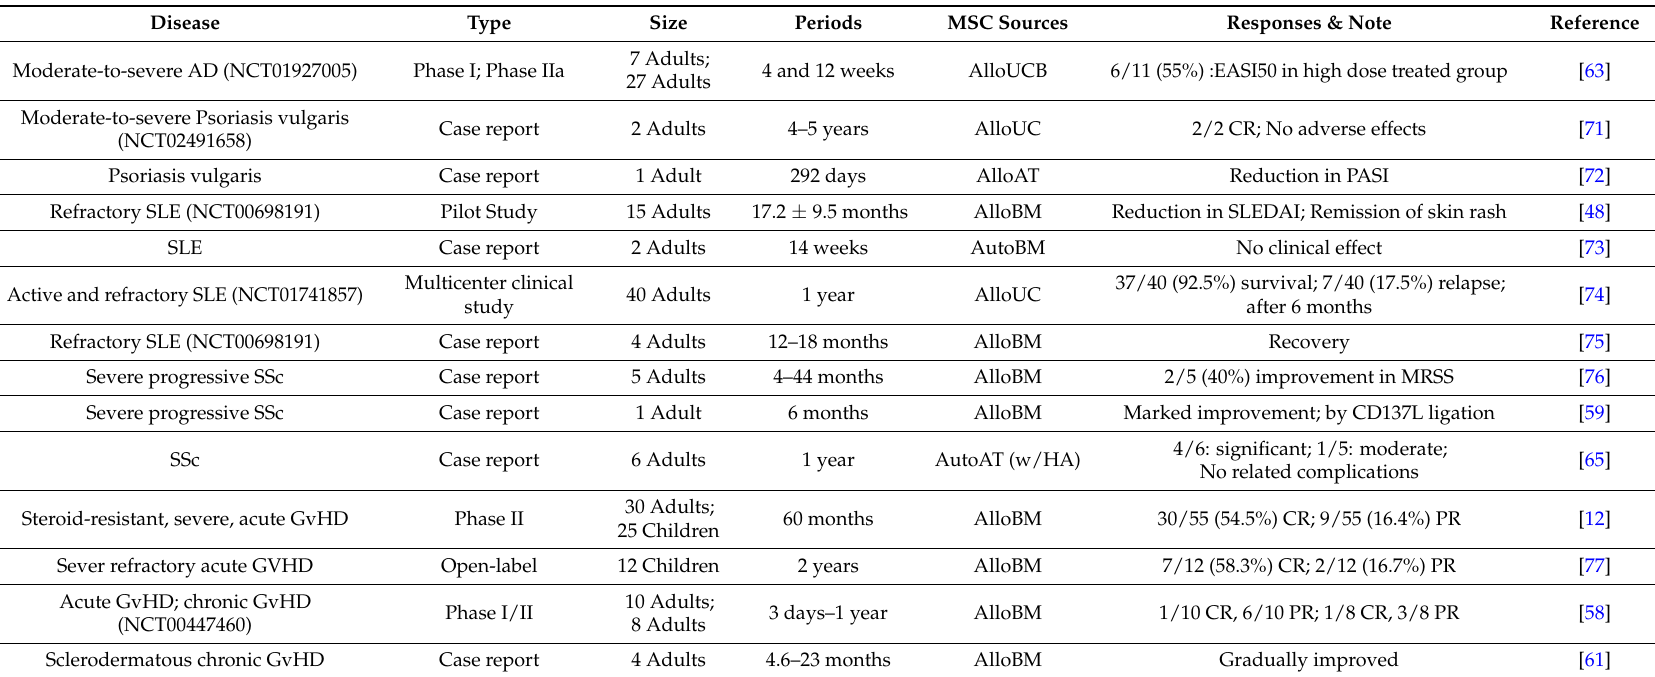
Table 2. Clinical applications of MSCs in inflammatory skin